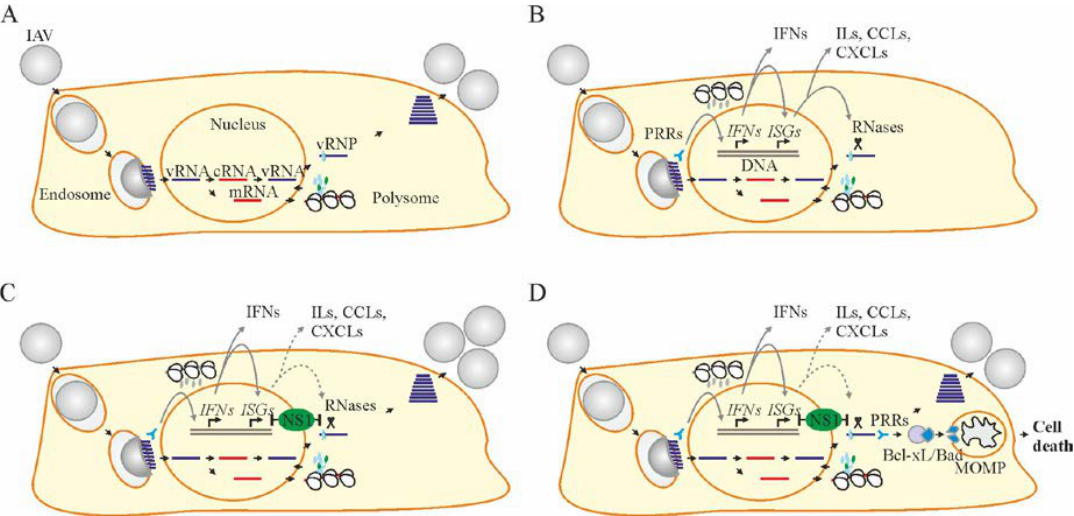
Figure 1. Influenza A virus (IAV) replication cycle, interferon (IFN) response, viral